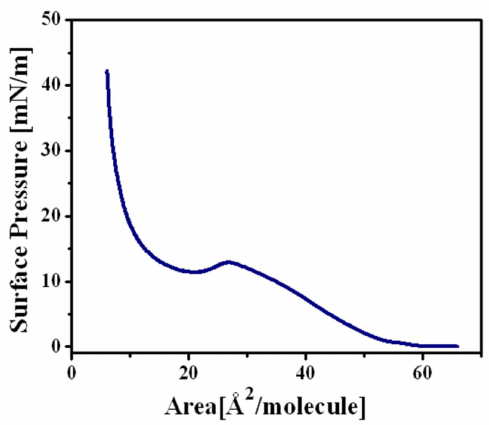
Figure 4. Surface pressure vs. area isotherm of phenyl aminocarbene complex 4a , M = Cr.